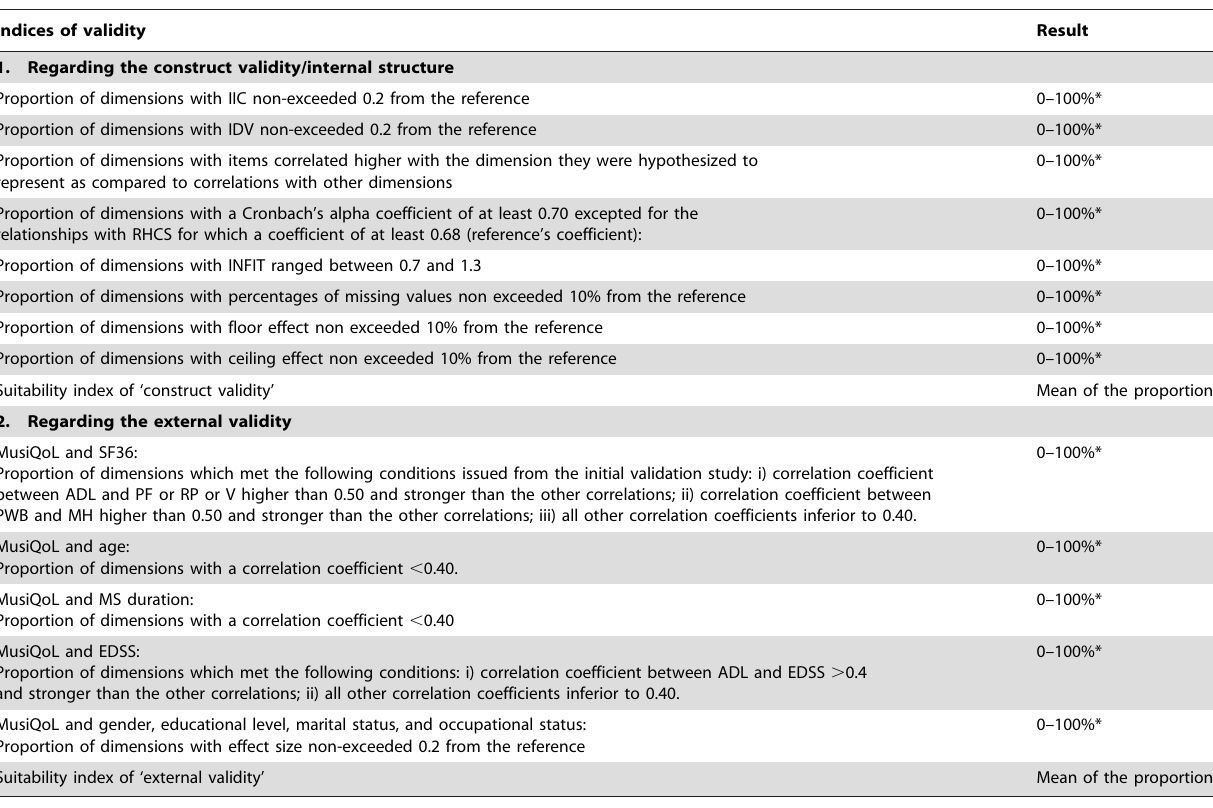
Table 2. The suitability indices: decision rules for the construct validity and the external